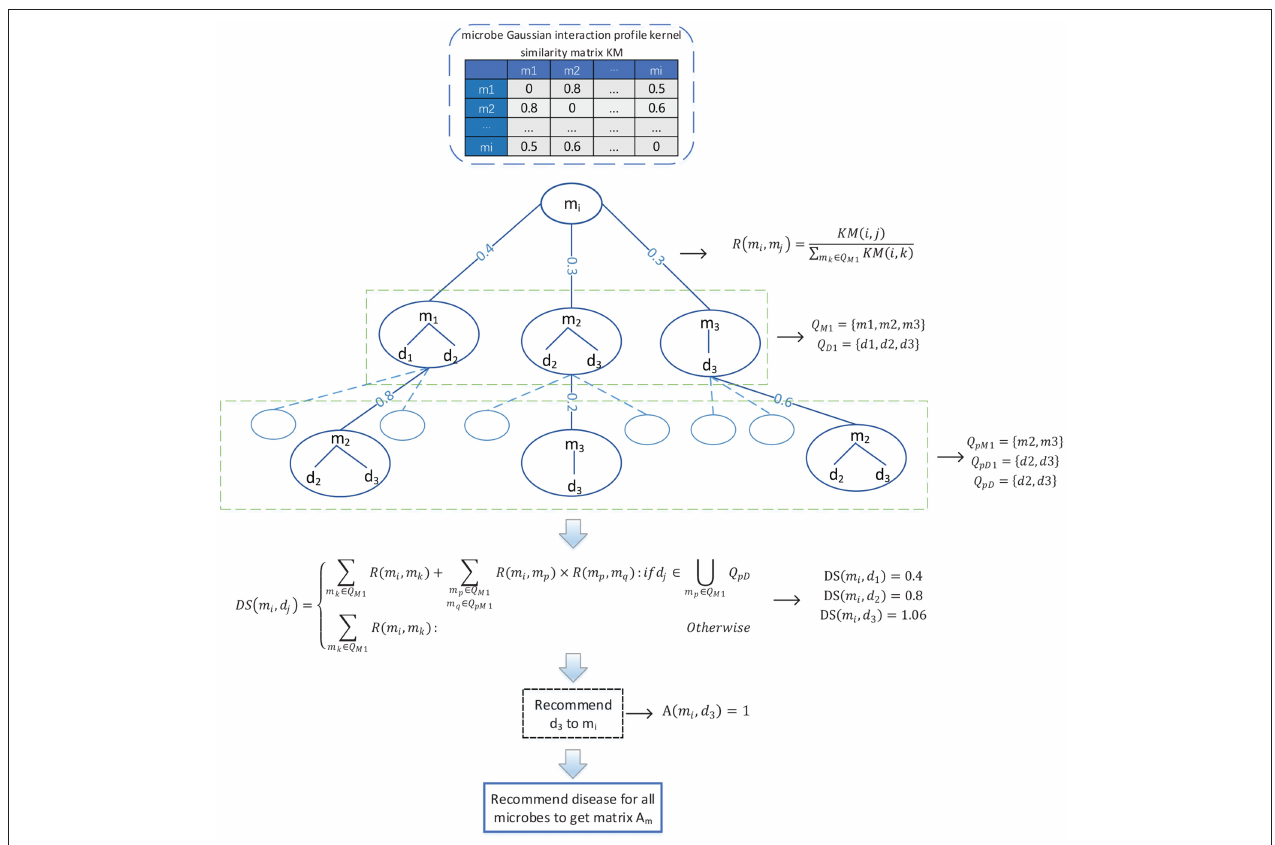
FIGURE 2 | Flowchart of the method utilized to recommend diseases to